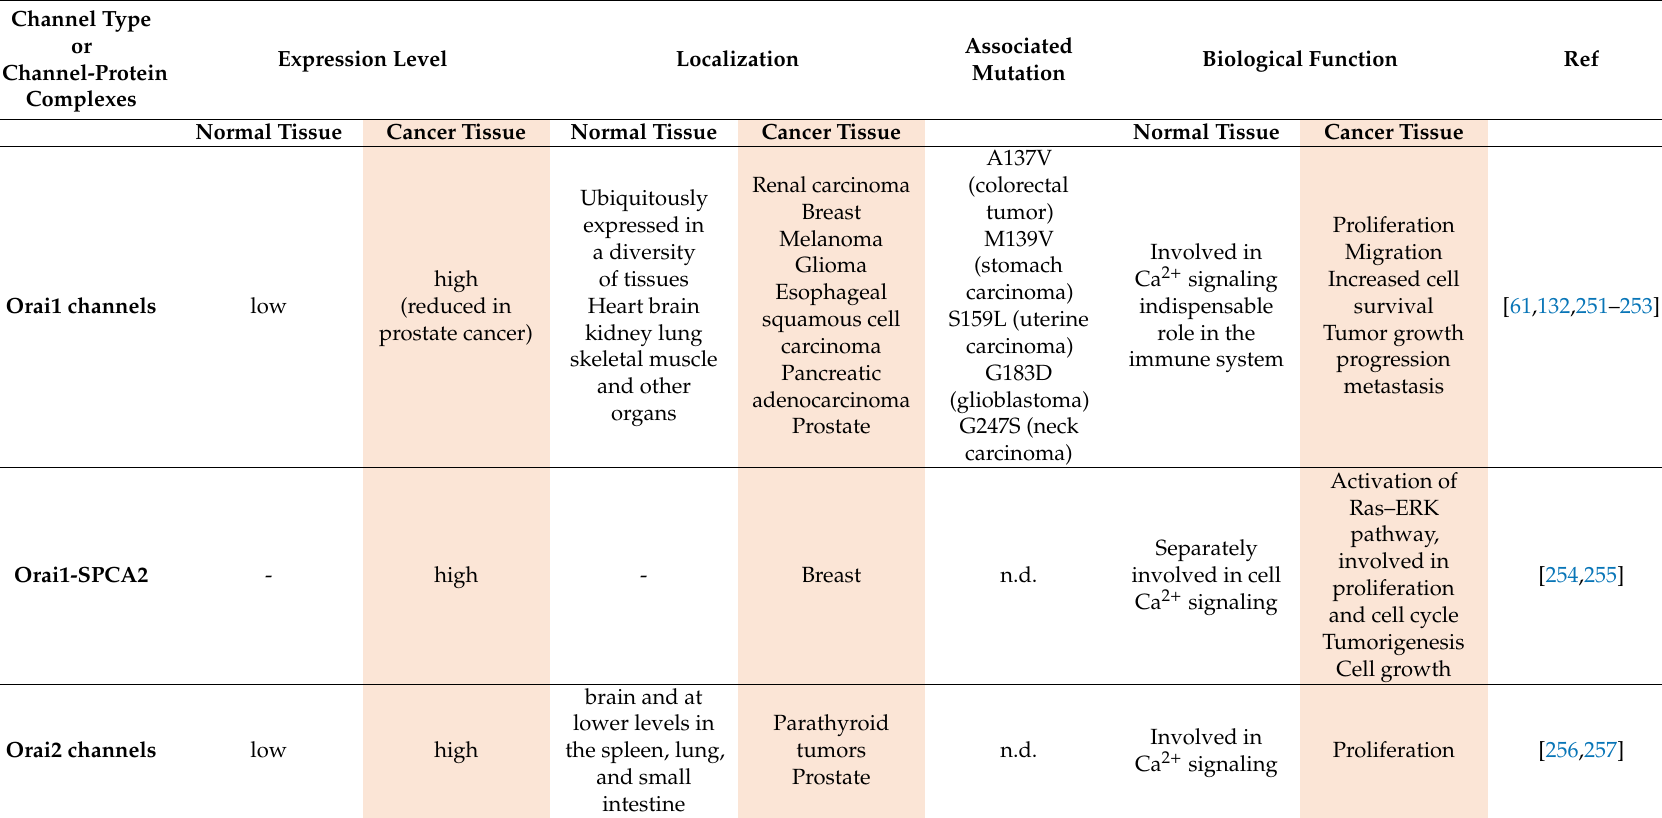
Table 2. Expression, localization, and biological functions of CRAC channel components and K or with accessory proteins. This table depicts the expression, localization, and biological functions of CRAC and K Moreover, disease-related mutations of the proteins are